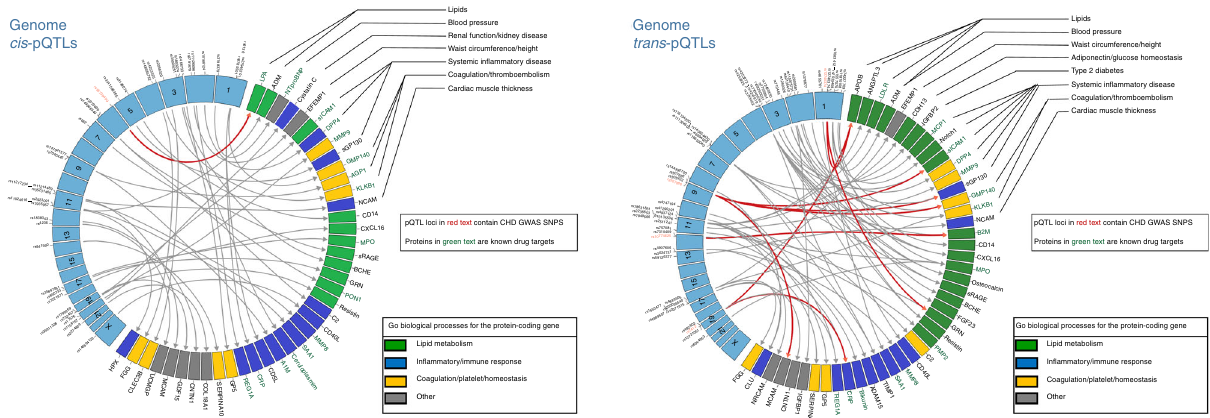
Fig. 2 Sentinel cis - and trans -pQTLs and their associated proteins. Circos plots of sentinel cis - (left panel) and trans -pQTL variants (right panel). Sentinel pQTL variants are listed in order of chromosomal locations (blue boxes in the left semicircle). pQTL variants previously identi fi ed in GWAS to be associated with CHD appear in red text. Proteins with genome-wide signi fi cant pQTLs are listed in the right semicircle. The following two conditions are summarized for each protein: (1) The corresponding protein-coding gene is a known drug target (green text). (2) GO biological processes for the protein- coding gene (green box denotes lipid metabolism pathways, blue box denotes in fl ammatory/immune response pathways, yellow box denotes coagulation/ platelet/hemostasis pathways, and gray box denotes other pathways not included in the three most common, previously listed pathways). A single primary GO process was chosen when the protein-coding gene was included in multiple pathways. CHD coronary heart disease, GO Gene Ontology, GWAS genome-wide association study, pQTL protein quantitative trait locus, SNP single-nucleotide polymorphism pQTL mapping . Using Bonferroni correction for multiple testing, we identi fi ed 16,602 pQTL variants (with Reference SNP cluster IDs) associated with 57 proteins (Supplementary Data 3), including 11,806 cis -pQTL variants (at P < 1.25E − 7, linear regression model unless otherwise stated) for 40 proteins and 4796 trans -pQTL variants (at P < 7.04E − 10) for 44 proteins; 27 80% power to detect a cis - or trans -pQTL variant that explained ≥ 0.6% of variance in protein levels (Supplementary Data 4). At